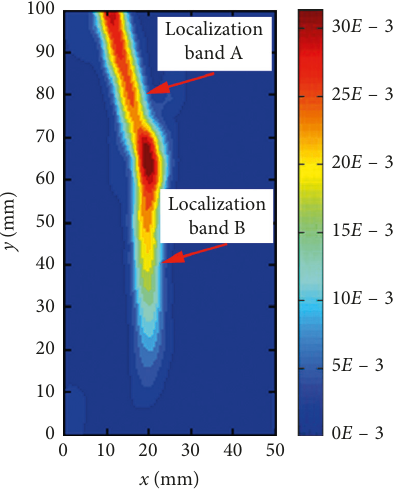
Figure 10: Nephogram of deformation field before failure.